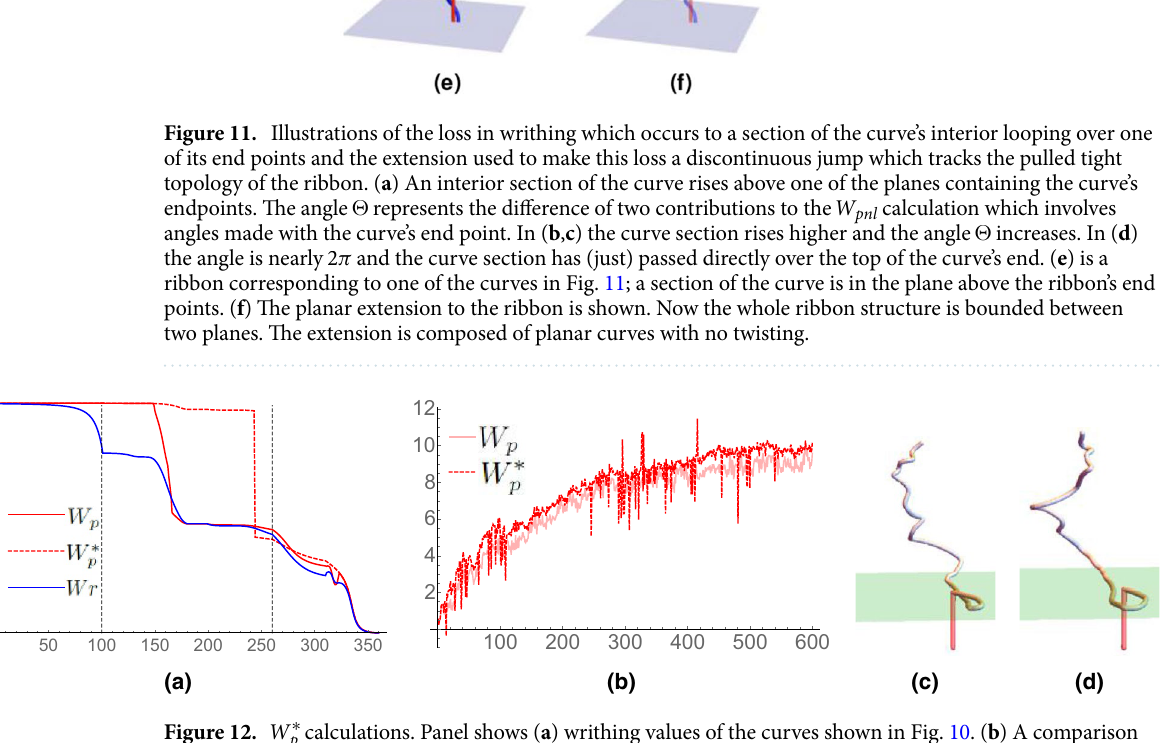
Figure 12. W ∗ p calculations. Panel shows ( a ) writhing values of the curves shown in Fig. 10. ( b ) A comparison of W p and W ∗ p for the overtwisted DNA simulations performed. ( c , d ) The detection of an over-the top deformation contributing one of the large jumps in the W ∗ p measure shown in ( b ). The end of the curve at neighboring timesteps and the end plane containing the point are shown in both ( c , d ). A red section of curve extending vertically downward from this point is shown (an extension used in the W ∗ p calculation in the WASP package). A section of the curve’s interior passes through this extension leading to a jump in the W ∗ p Knot undoing. The curves depicting the undoing of a knot in Fig. 10 are part of a continuous set of deforma- tions. This deformation was discretized into 360 steps. The first 100 steps, Fig. 10a,b, are simple in that the shape of the knotted (trefoil) curve does not change but its size with respect to the straight end extensions is increased; in short, the shape of the curve is effectively unchanged. From curve 101 to 260, the knot is undone as a sec- tion of the curve loops over its top end point, Fig. 10b–d. Then, from step 261–360, the curve is pulled straight (Fig. 10d–f). The net effect is the undoing of a knot. The values of W p , W ∗ p and Wr (given by (13)) are shown in Fig. 12. For the first 100 steps, both W p and W ∗ p are identical and unchanged, correctly representing the fact the knot’s shape is essentially unchanged and the corresponding net winding would not change (assuming as always that the ends of the ribbon are prevented from untwisting). The Wr calculated via the Gaussian integral (Eq. (13)), however, does change. The reasons for this change are somewhat technical and are discussed in the supplement; it suffices to note here that it is not characterizing the knots unchanging shape and the sum W r + Tw would not be a fixed quantity.